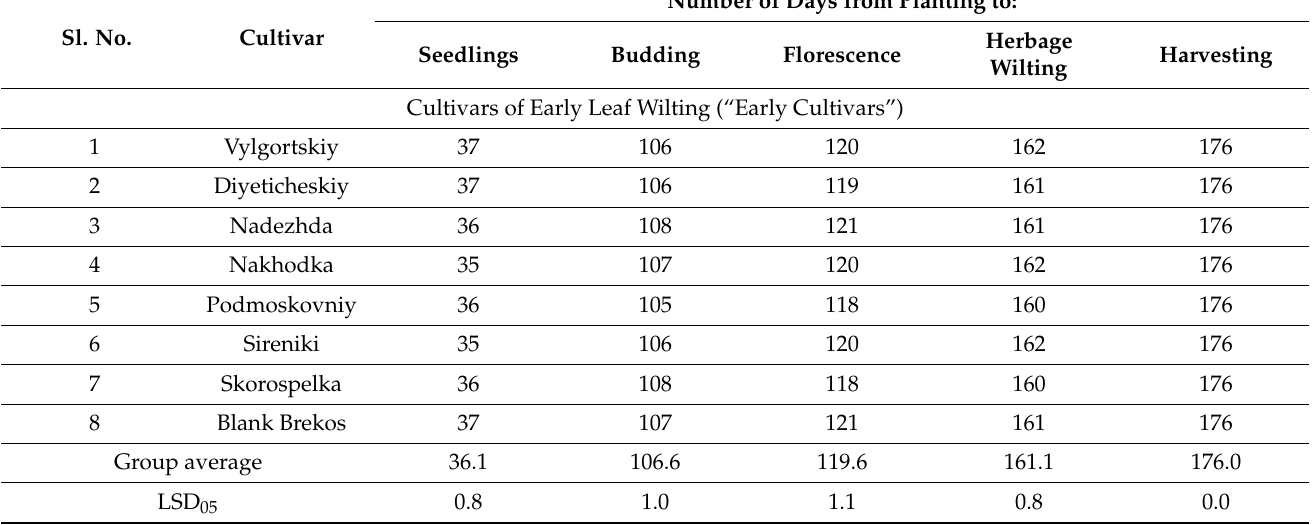
Table 1. Results of phenological observations and biometric indicators records (on average for